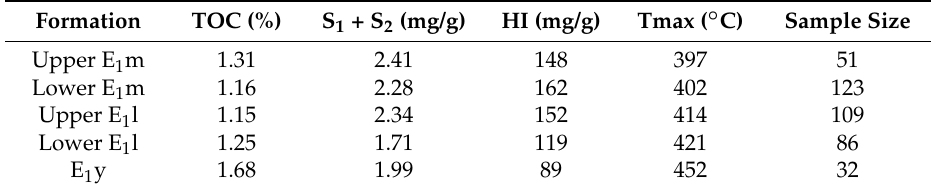
Figure 7. Distribution maps of root-mean-square (RMS) amplitude of each system tract in the reservoir interval, with uniform value ranges for RMS amplitude. The undefined value areas are faults and Lingfeng Uplift areas where gaps exist in the seismic data. Table 3. The average value of source rock pyrolysis test data used in the model. TOC = Total organic carbon, S 1 = Free hydrocarbon components, S 2 = Hydrocarbons generated by the pyrolysis, HI = Hydrogen index, Tmax = Pyrolysis peak